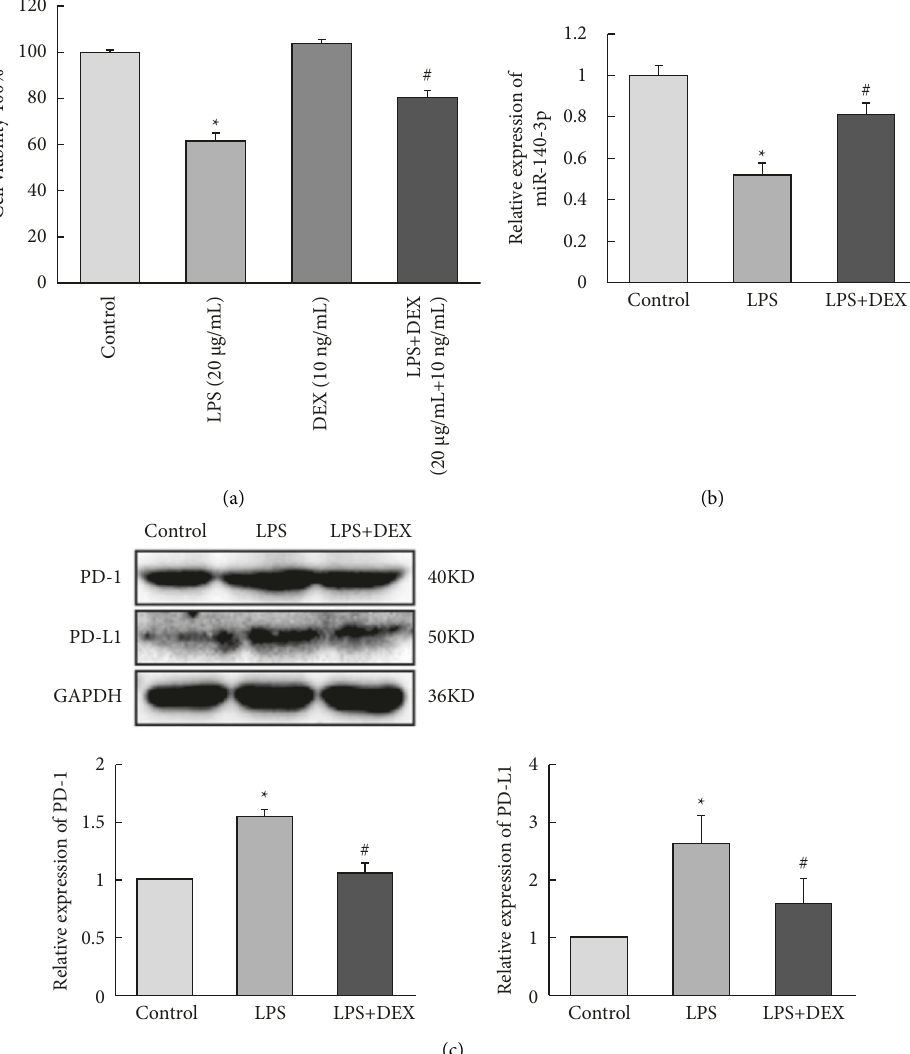
Figure 1: DEX protects alveolar epithelial cells from inflammation by promoting miR-140-3p level and suppressing PD-1/PD-L1 ex- pression. (a) The survival rate of RLE-6TN cells induced by LPS and DEX. (b) The relative expression of miR-140-3p in RLE-6TN cells induced by LPS and DEX. The relative expression of PD-1/PD-L1 in RLE-6TN cells induced by LPS and DEX. Data are presented as means ± SD ( n � 3; compared to control ∗ p < 0 . 05, compared to LPS-induced # p < 0 .